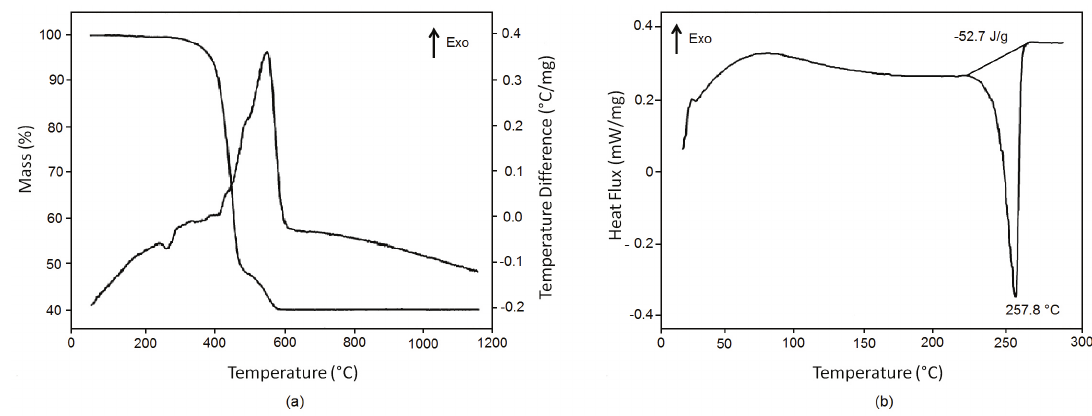
Figure 2. (a) TG/DTA curve of fragmented dosemeters and (b) DSC curve obtained during heating of the dosemeter polymer layer.